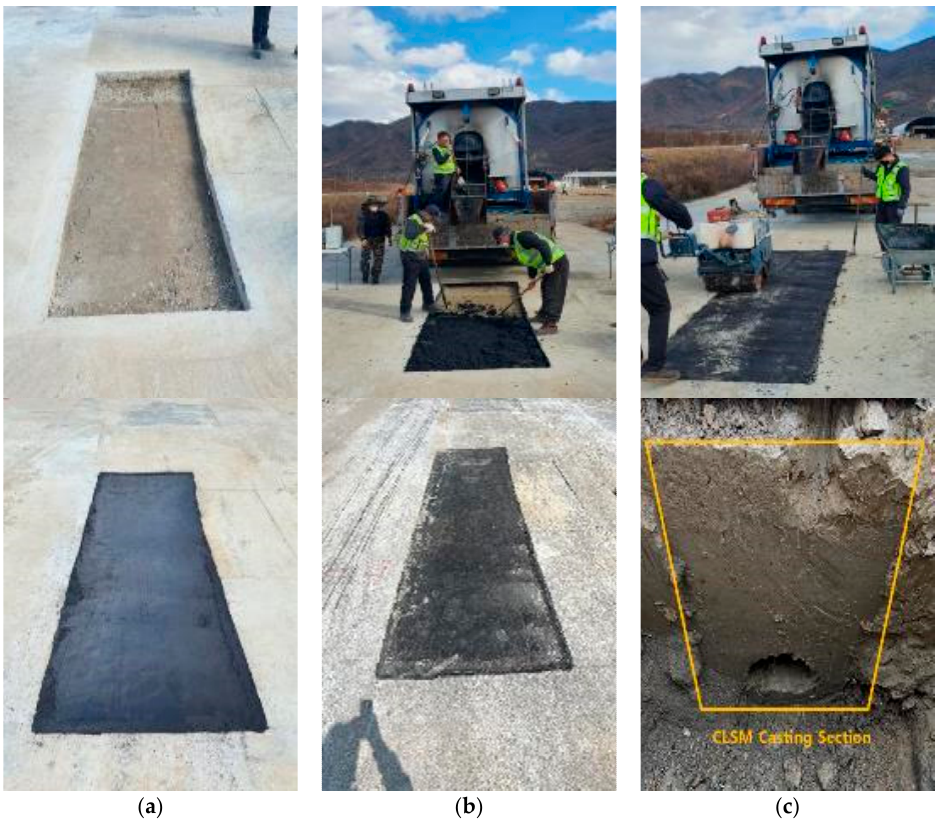
Figure 12. Field application monitoring results for CLSM using stone sludge. ( a ) After construction; ( b ) After 5 months; ( c ) CLSM cross-section.